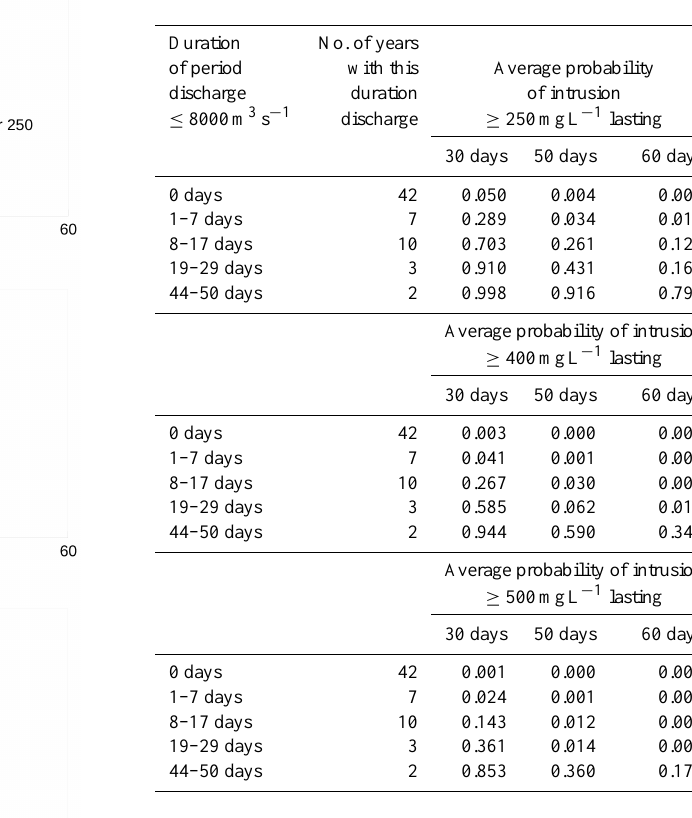
Table 3. Probability of intrusion duration and intensity in relation to length of periods of low discharge.